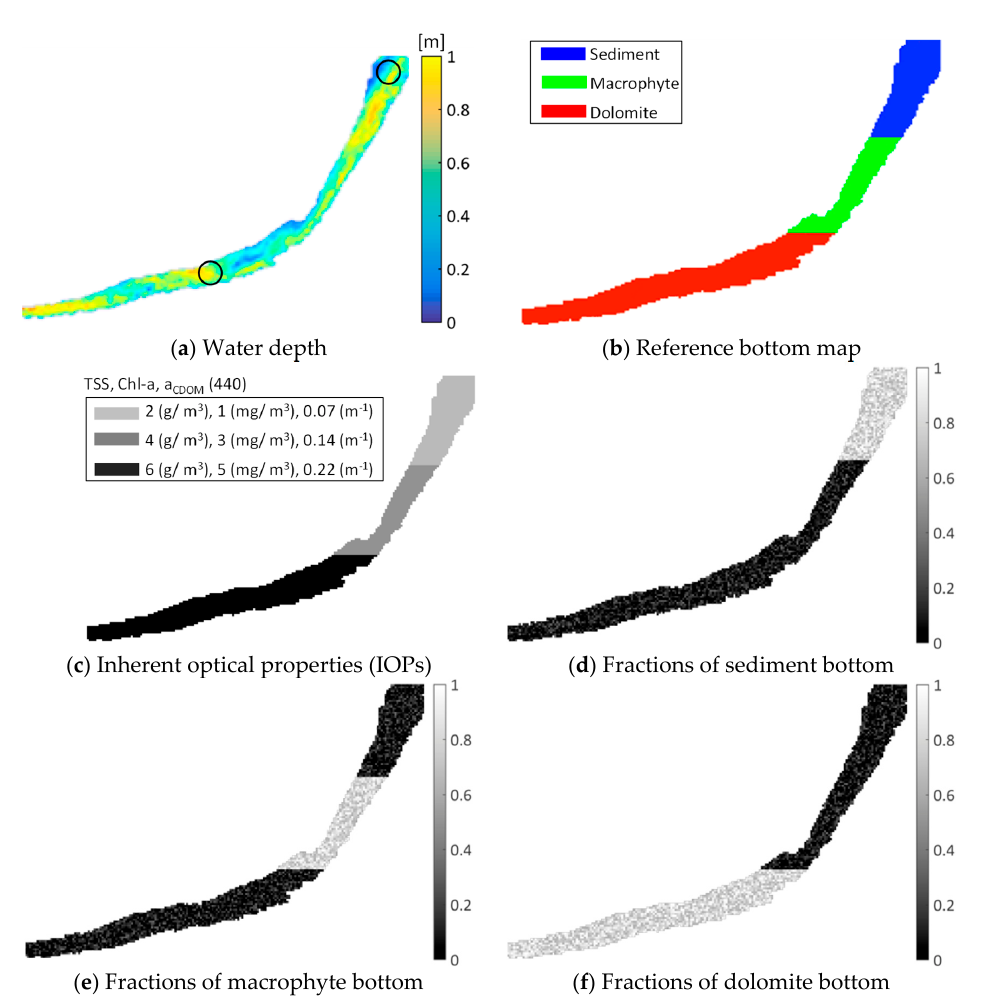
Figure 7. Inputs for simulation of spectra across the river channel ( R Sim _ Channel rs ) associated with ( a ) water depths in a reach of the Sarca River considering ( b ) dominant bottom types, ( c ) variable constituents, and ( d – f ) fractions of bottom types. A linear mixture model (Equation (9)) was applied to account for the variability (fractions) of bottom types within the pixels. Two test sites used for the estimation of K d are highlighted by circles on the first